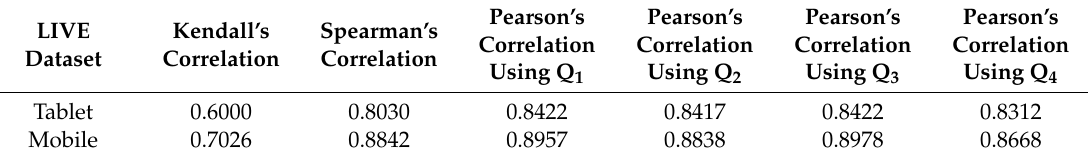
Table 8. Kendall’s, Spearman’s, and Pearson’s correlation for the overall frame freezing dataset, using the LIVE tablet sub-dataset for training and the LIVE mobile sub-dataset for testing.